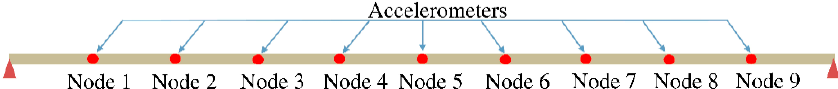
Figure 4. Locations of accelerometers to record acceleration data.